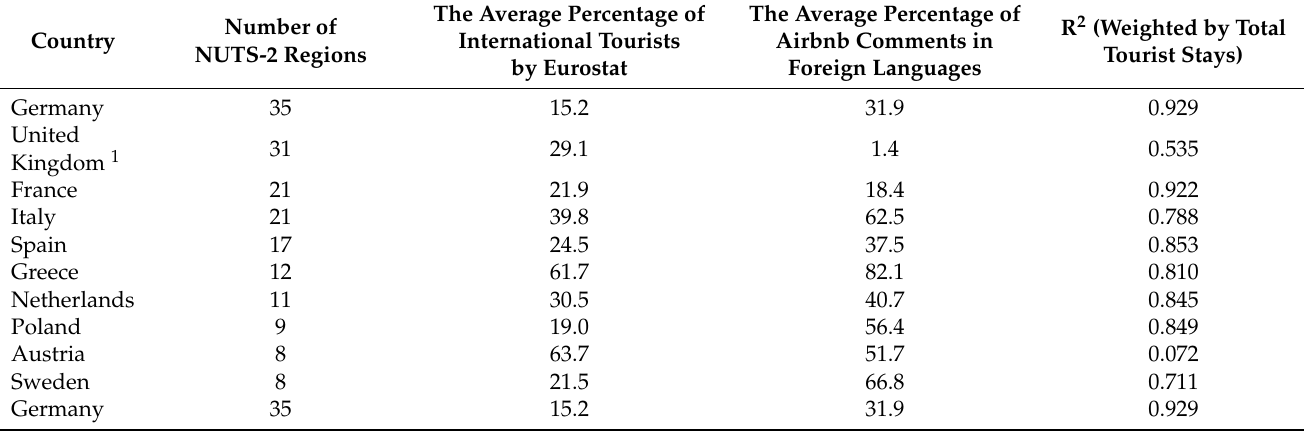
Table 4. Correlation between the percentage of international visitors and the percentage of Airbnb reviews written in foreign languages in NUTS-2 regions of European countries in